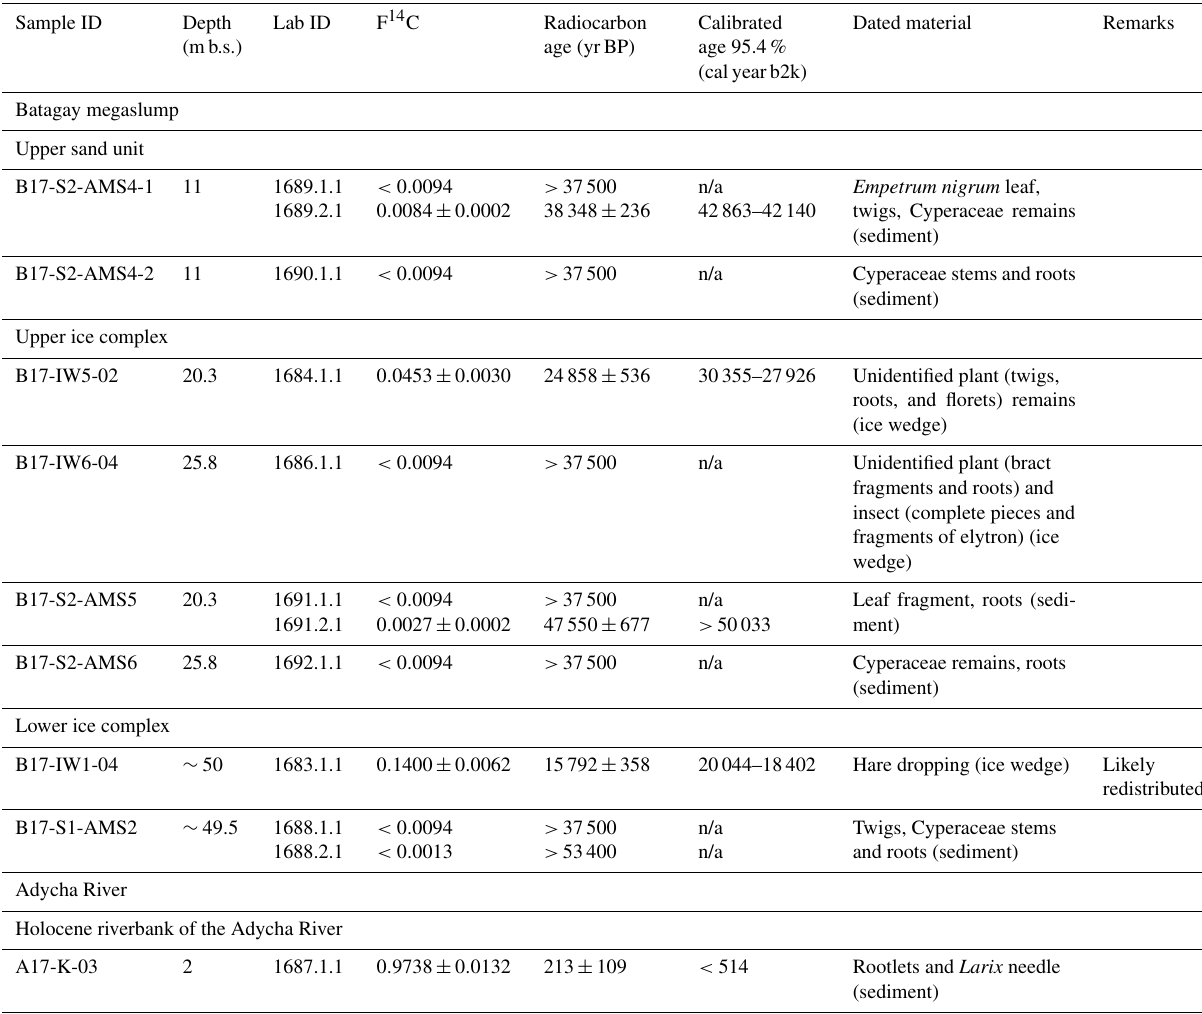
Table 3. Radiocarbon ages of organic remains in ice wedges (sample ID includes IW) and host sediments of the Batagay megaslump and at the Adycha River. The samples were radiocarbon dated as gas targets (lab ID ends with 1.1) and graphite targets (lab ID ends with